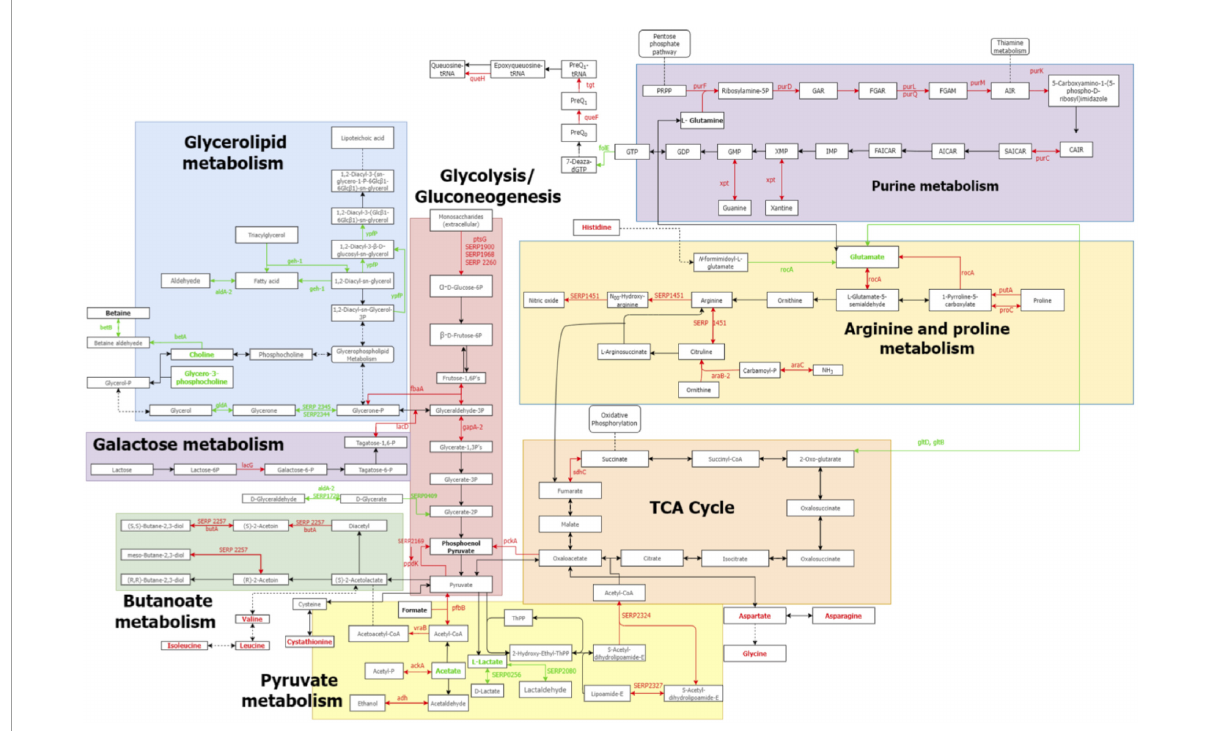
FIGURE7 Metabolic pathways altered between N55 vs N77 based on the proteomic and metabolomic data. Reconstruction of the principal metabolic pathways that changed in S. epidermidis 19N when growth at blood pH (N77) when compared with skin pH (N55). Names of metabolites and enzymes increased in N77 are in red, while those increased in N55 are in green. Metabolites determined in the study but that do not show significant differences are in black, while metabolites undetected are in grey. Full arrows represent reactions, dashed arrows represent connections with other pathways or hidden